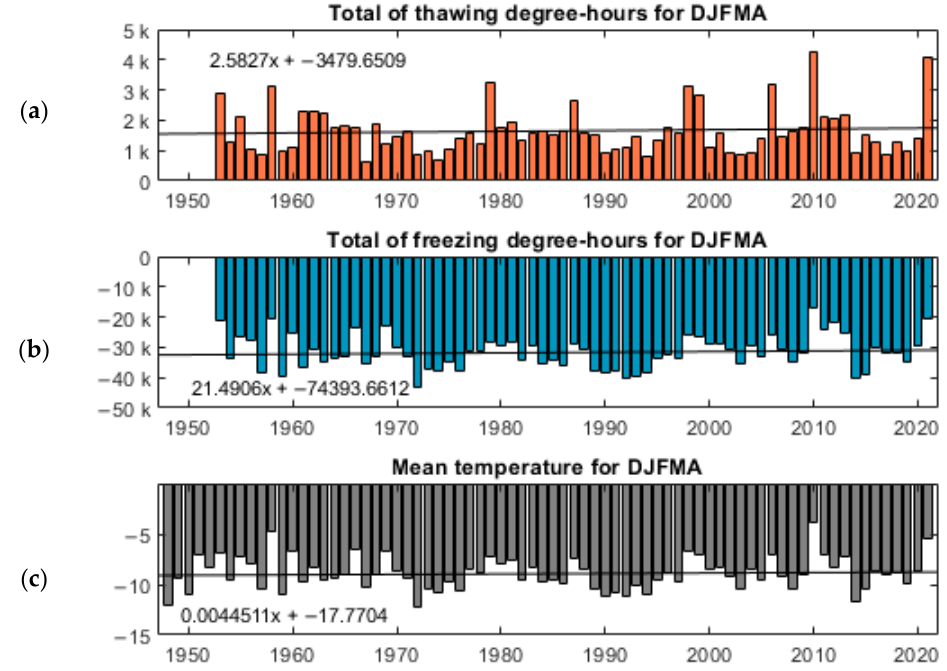
Figure 24. Air temperature inter-annual variation for December, January, February, March, and April (DJFMA). ( a ) Total of thawing degree hours for DJFMA; ( b ) total of freezing degree hours for DJFMA; ( c ) mean temperature for DJFMA.